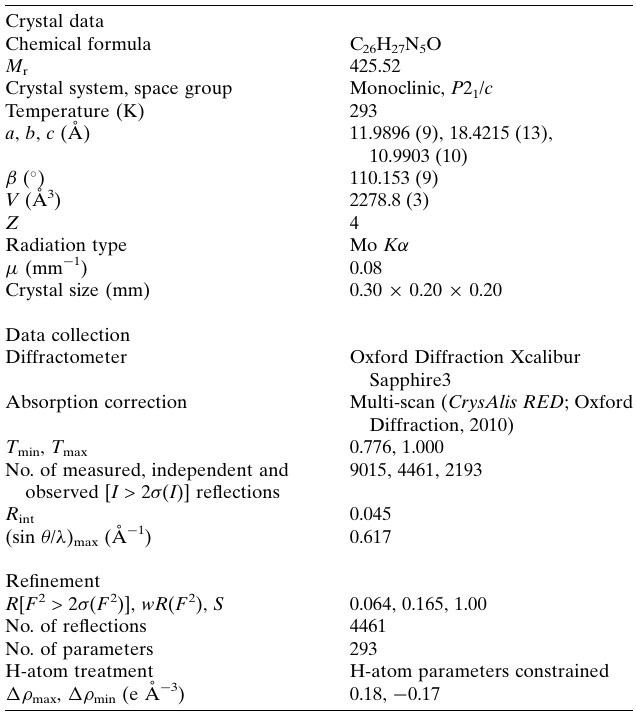
Table 2 Experimental details.